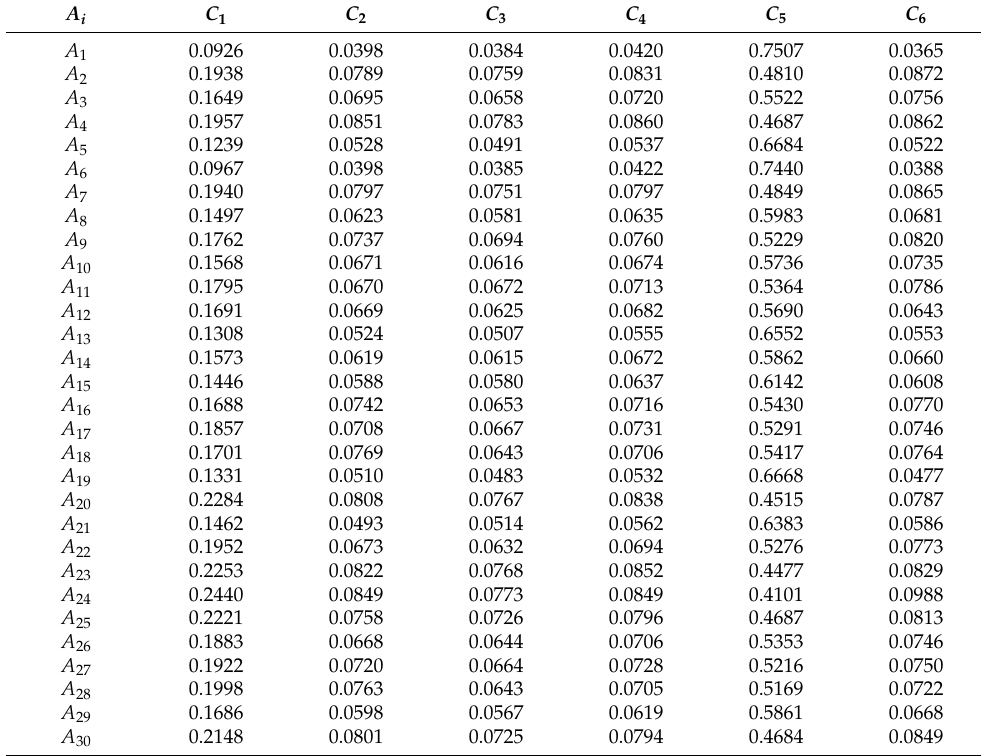
Table 8. Local weights for